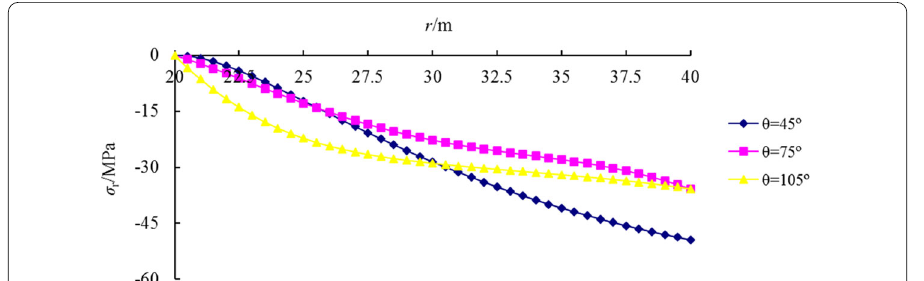
Figure 4 Distribution of radial stress for three different sections